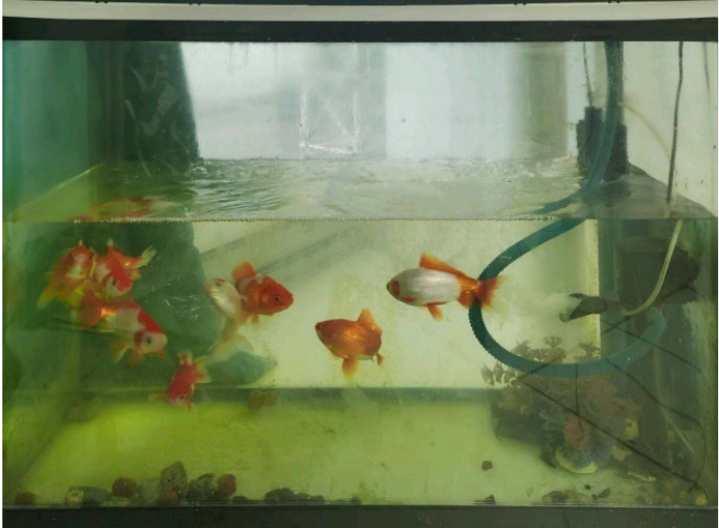
Figure 1. Ten different crucian carp lived in the water tank under the experimental environment.